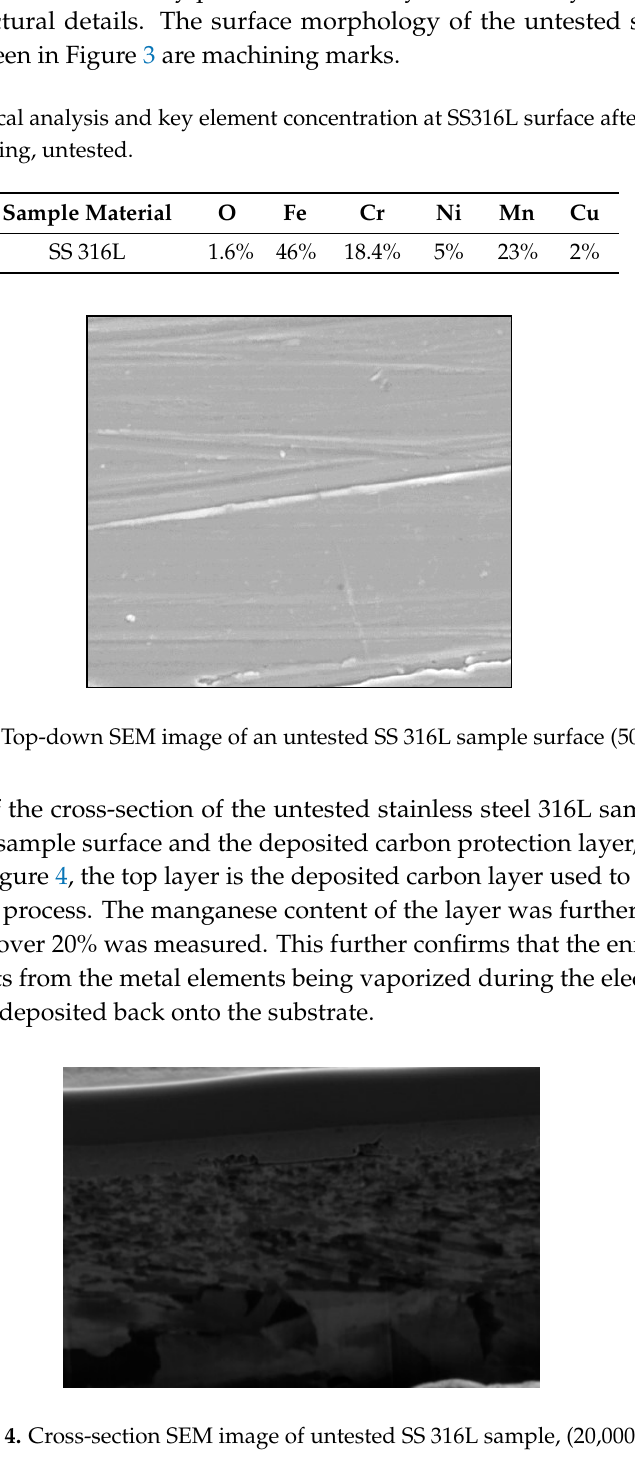
Table 4. EDX chemical analysis and key element concentration at SS316L surface after machining and Electron Beam welding, untested.